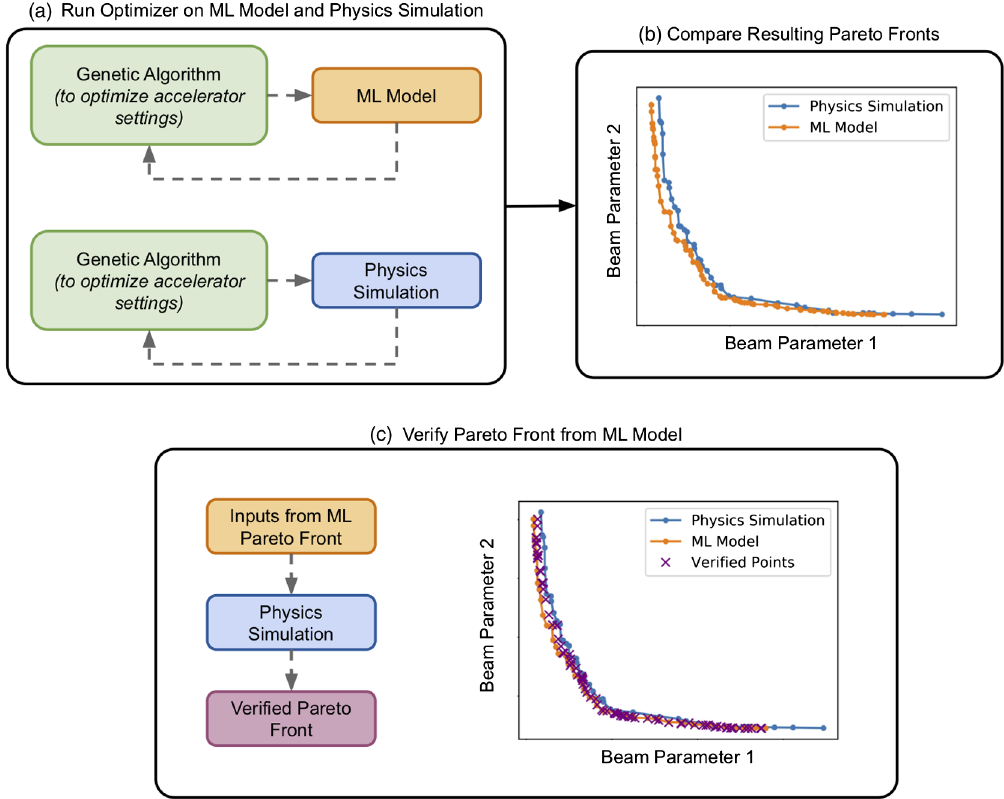
FIG. 2. Approach for assessing the reliability of ML-based model when used for optimization of beam parameters. We run a GA with the physics simulation to find accelerator settings (e.g., rf cavity phases, rf cavity gradients, solenoid strengths) that optimize the beam parameters. The optimization is repeated using the ML model instead of the physics simulation. We then compare the estimated Pareto fronts for key beam parameters. Finally, we run the inputs corresponding to the estimated Pareto front predicted by the ML model through the simulation to verify the accuracy of the